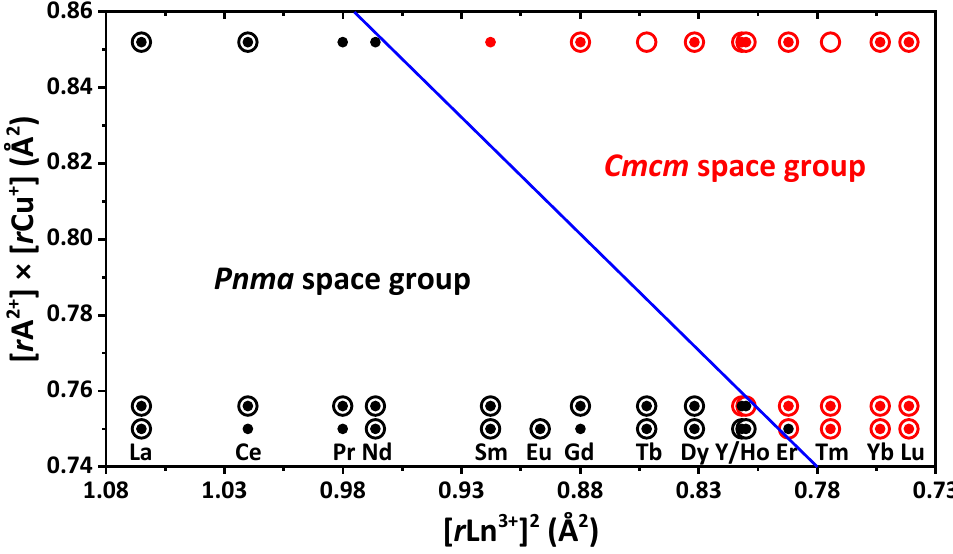
Figure 4. Discrimination between space groups for the structures of ALnCuS 3 (filled circles) and ALnCuSe 3 (open circles) depending on the ionic radii of the metal ions. A = Ba (top row), Sr (middle row) and Eu (bottom row).